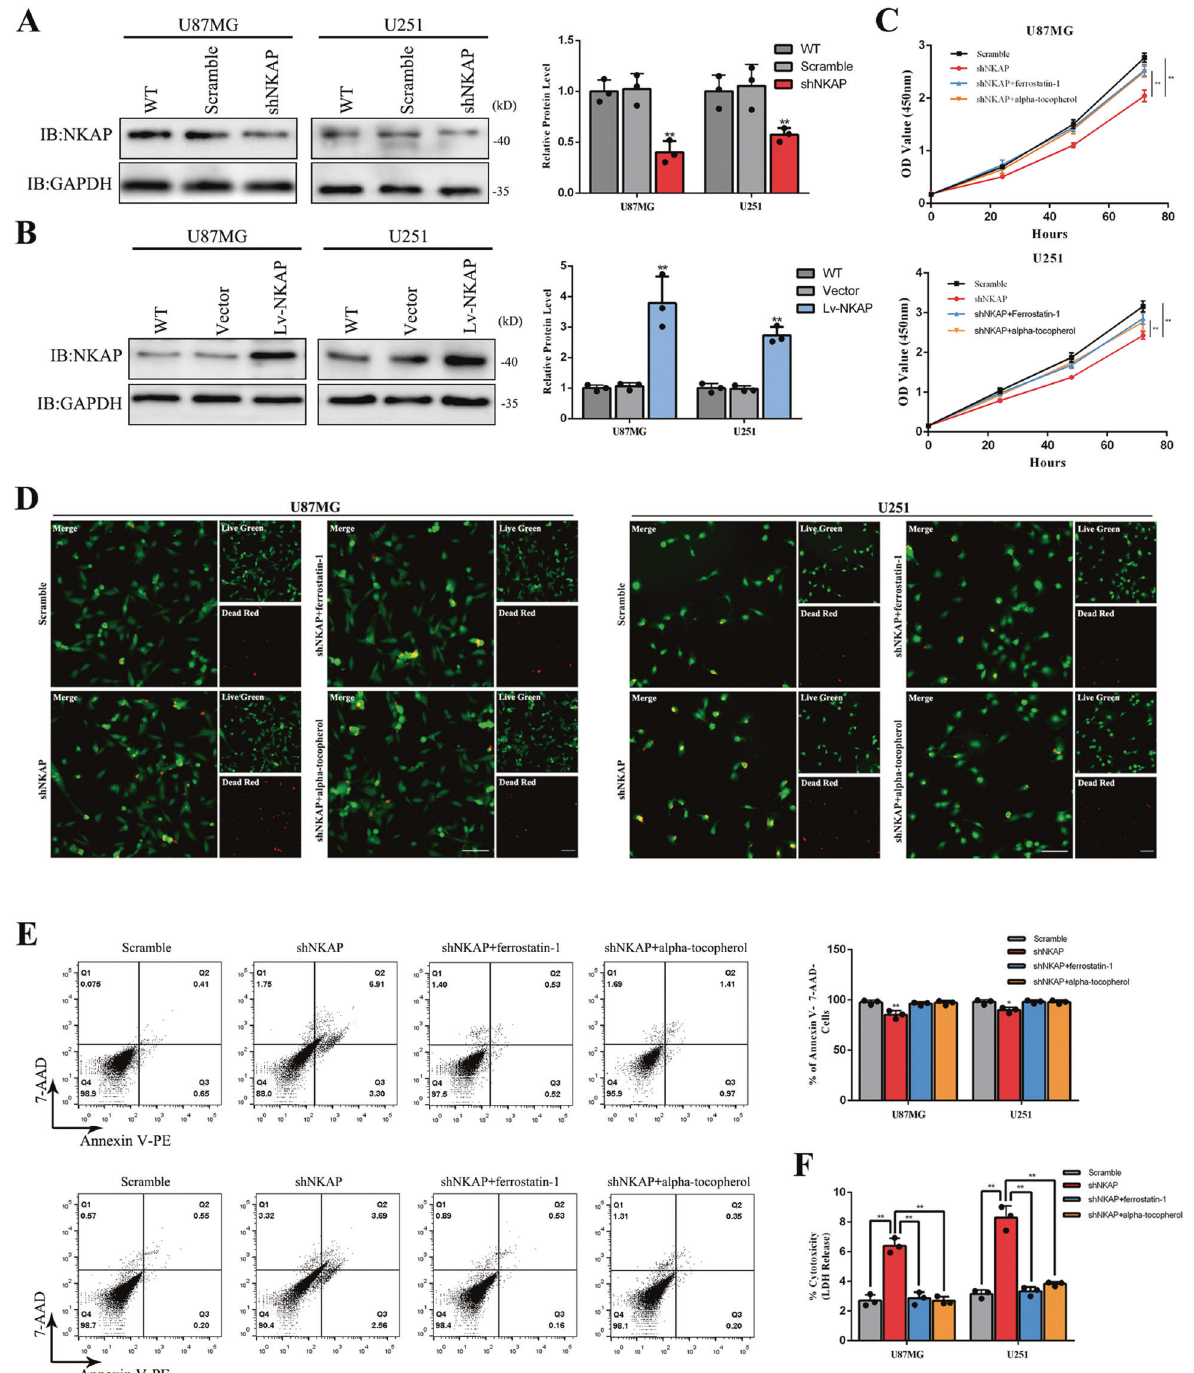
Fig. 1 NKAP knockdown caused an increased percentage of cell death in glioblastoma cell lines. A The interference effect of shNKAP in U87MG and U251 cell lines. GAPDH was used as a loading control. B Protein overexpression level induced by Lv-NKAP in glioblastoma cell lines. GAPDH was used as a loading control. C The growth curves of the U87MG and U251 cells were examined using a CCK-8 assay. Cell growth was inhibited by NKAP knockdown and partially reversed by 0.5 μ M ferrostatin-1 or 5 μ M alpha-tocopherol for 24 h. D Live (green)/ dead (red) staining revealed a higher cell death rate in the shNKAP group, which could be reversed by 0.5 μ M ferrostatin-1 or 5 μ M alpha- tocopherol for 24 h. Scale bar = 100 μ m. E Cell death induced by NKAP knockdown in the absence or presence of 0.5 μ M ferrostatin-1 or 5 μ M alpha-tocopherol for 24 h detected by fl ow cytometry in U87MG and U251 cell lines. F LDH release induced by NKAP knockdown in the absence or presence of 0.5 μ M ferrostatin-1 or 5 μ M alpha-tocopherol for 24 h. All bars show the mean ± SD of three independent experiments. * P < 0.05, ** P <